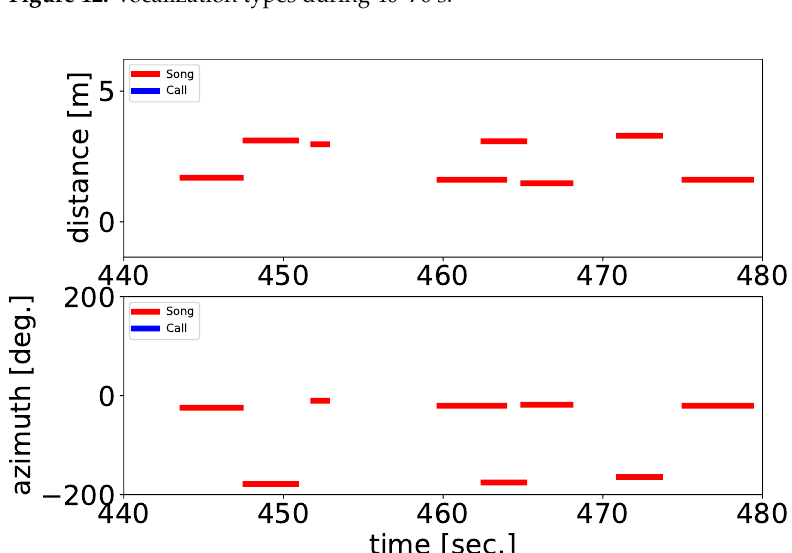
Figure 12. Vocalization types during 40–70 s.